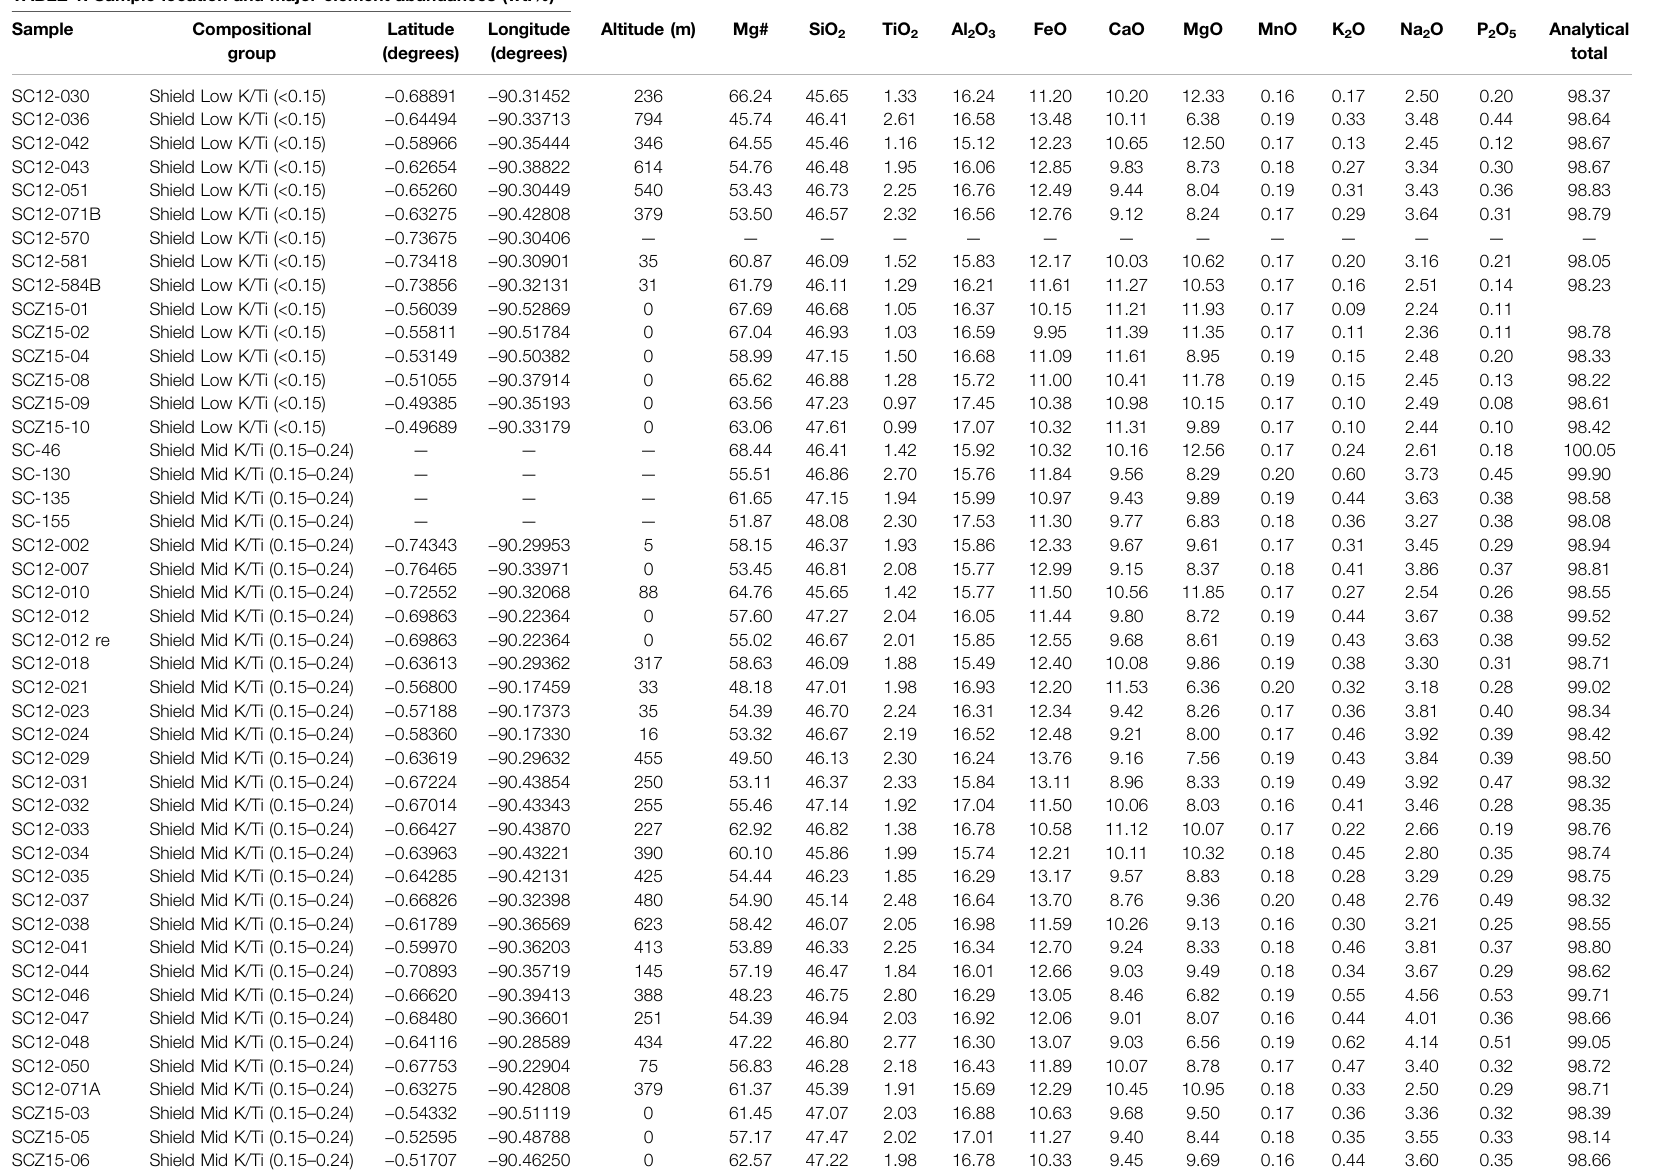
TABLE 1: Sample location and major element abundances (wt.%) Sample Compositional group SC12-030